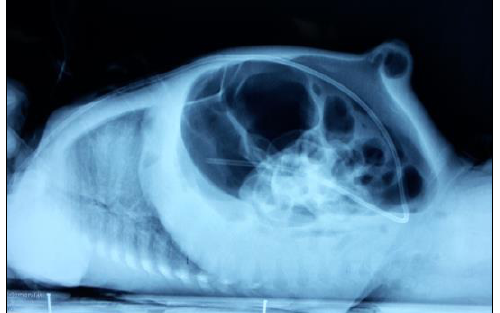
Figure 1: Abdominal roentgenograms showing gross pneu- moperitoneum.